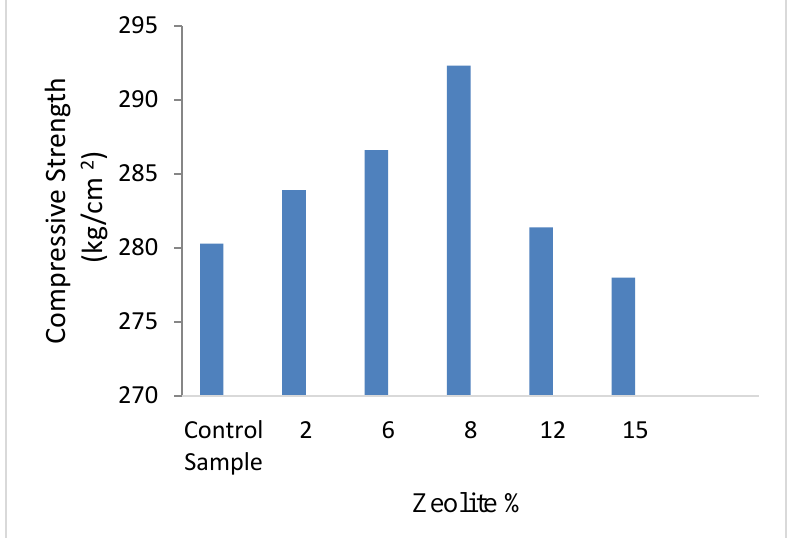
Fig. 12. Concrete strength with different percentages of Zeolite with 320 grade cement at 28 days of